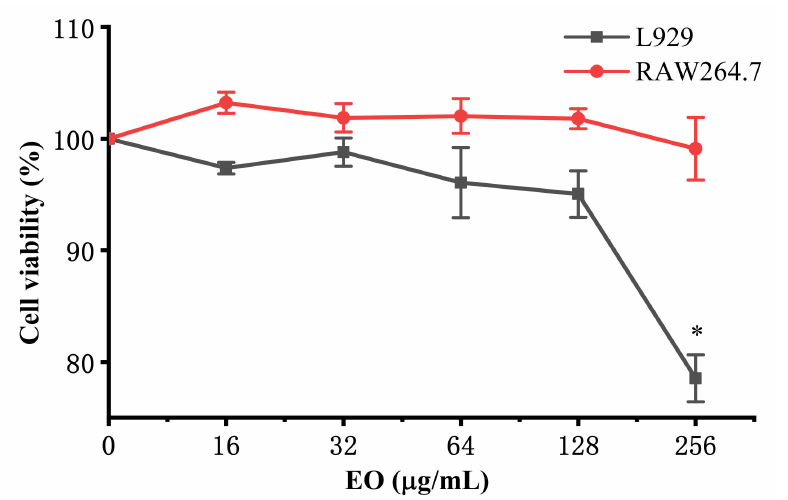
Figure 2. The effect of R. beesianus rhizome EO on the cell viability of RAW264.7 (murine macrophage cells) and L929 (murine fibroblast cells). L929 and RAW264.7 cells were pre-treated with different concentrations of R. beesianus EO for 24 h, and the cell viability was assayed by 3-[4,5-dimethylthiazol- 2-yl]-2,5 diphenyl tetrazolium bromide (MTT) assay. The results were expressed as the percentage (%) of viable cells compared to the untreated cells and showed the mean ± standard deviation (SD). * p < 0.05, compared to the control